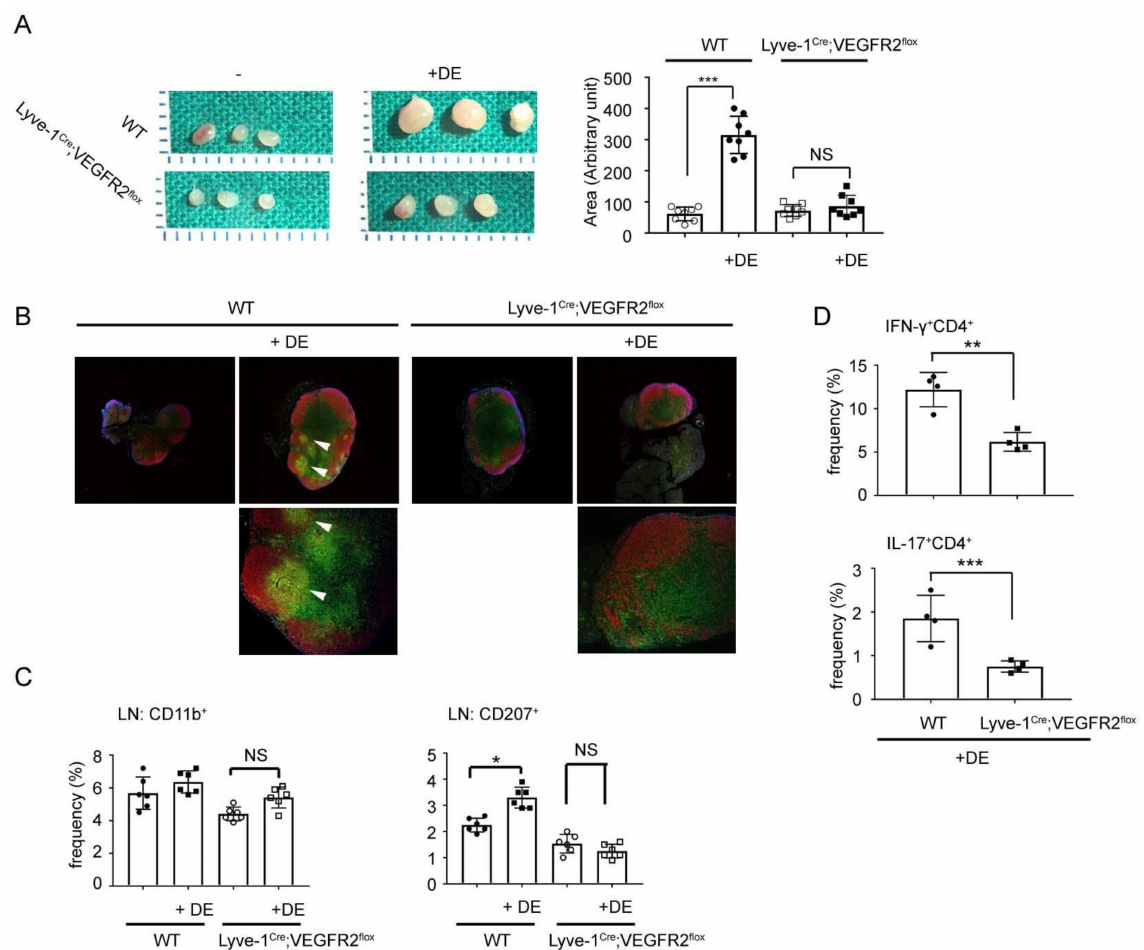
Figure 6. Morphohistological and cellular compositional changes of draining lymph nodes by dry eye induction in Lyve-1 Cre ;VEGFR2 flox mice. ( A ) Representative images of draining lymph nodes (LNs) from naïve and dry eye (DE)-induced mice. To determine LN size, at least three draining LNs from naïve and DE-induced female mice were measured using ImageJ software. Five mice, for a total of 15 LNs per group, were included in the calculation. ( B ) Confocal microscopy image of a draining LN section stained with CD3 (yellow) and B220 (red). White arrowheads indicate T and B cell mixed zone between corticomedullary junctions (magnification: 50 × in upper row; 100 × in lower row). ( C , D ) Flow cytometric analysis of CD11b + , CD207 + , IFN- γ + CD4 + , or IL-17 + CD4 + cells obtained from draining LNs. Cell frequencies were measured with three independent experiments at 0 and 7 days after DE induction. Data are represented as means (bars) ± standard deviations (error bars) (***, p < 0.001; **, p < 0.01; *, p < 0.05, by one-way ANOVA with Dunnett’s post hoc test or independent t -test; NS, no statistical significance) (Ref.